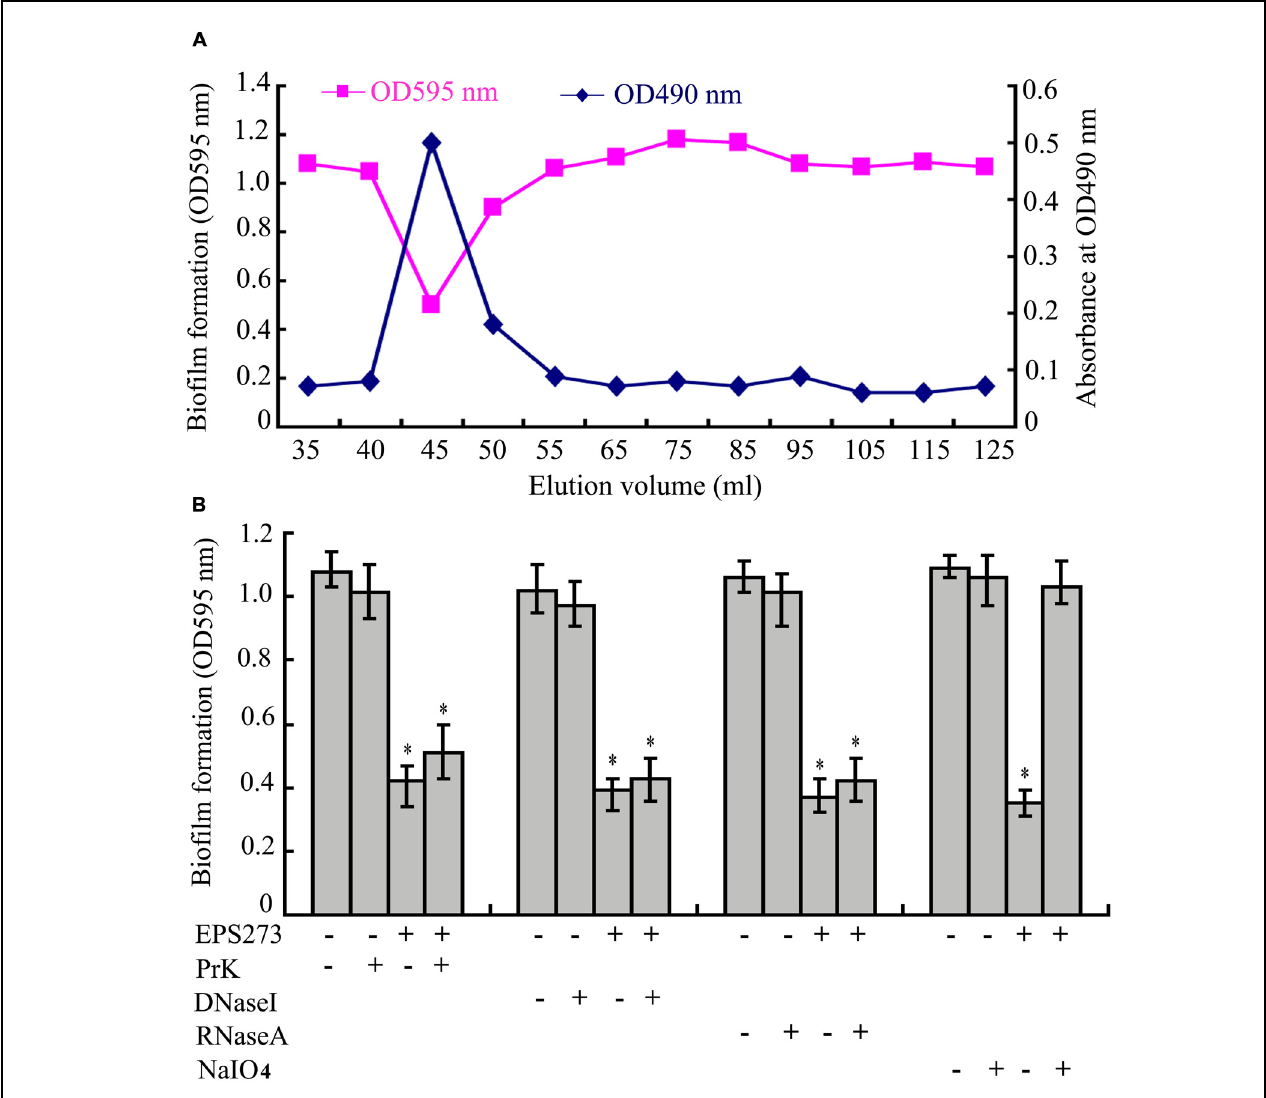
FIGURE 2 | Purification and identification of active component of EPS273. (A) The profiles of the fractions in the gel filtration, which were collected and monitored for the biofilm formation determined at OD595 nm after crystal violet staining and polysaccharide content determined at OD490 nm after the phenol-sulfuric acid assay. (B) Effects of Proteinase K, DNase I, RNase A and NaIO 4 on the activities of EPS273 inhibiting biofilm formation of P. aeruginosa PAO1. EPS273 (0.1 µ g/mL) was, respectively, treated with proteinase K (PrK) (1 mg/mL), DNaseI (100 µ g/mL), RNaseA (100 µ g/mL) for 1 h or NaIO 4 (10 mM) for 12 h at 37 ◦ C, then taken to measure the antibiofilm activity. Error bars represent standard deviations of three independent experiments. Error bars indicate the standard deviations of three measurements. ∗ P < 0.05 versus the control.